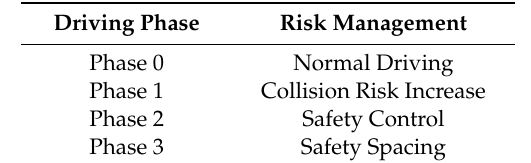
Table 1. Risk management and driving phase [21].